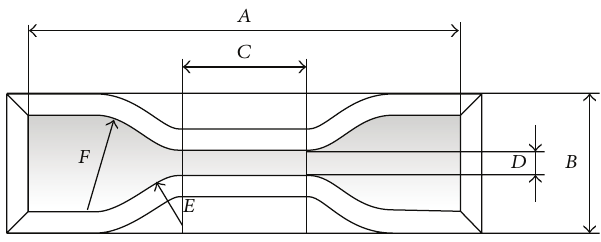
Figure 1: Shape of dumbbell test specimens produced according to type 1 of the ISO 37:2005 specifications and/or type C of ASTM.D412 specifications. The actual extent of the dimensions indicated by uppercase letters is specified in Table